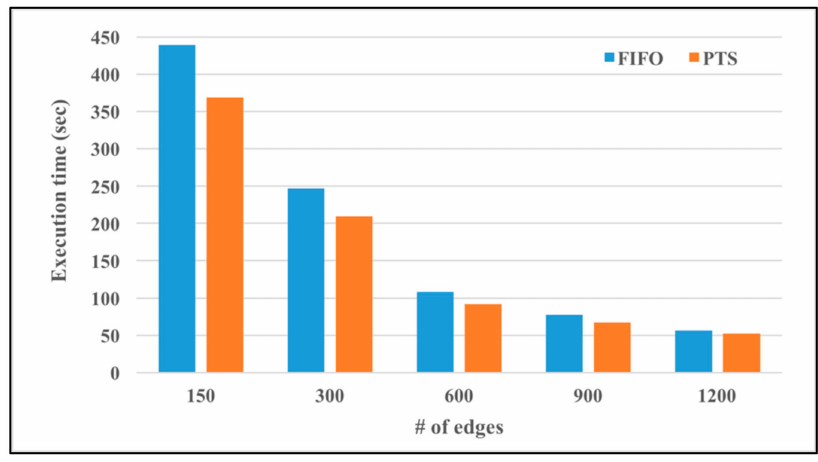
Figure 14. Execution time of executing SparkTC by FIFO and proactive task scheduling (PTS) approaches.